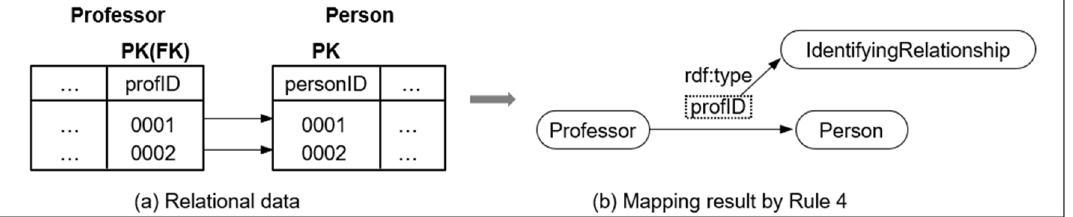
Figure 13. An example of mapping an identifying relationship (Rule 4).